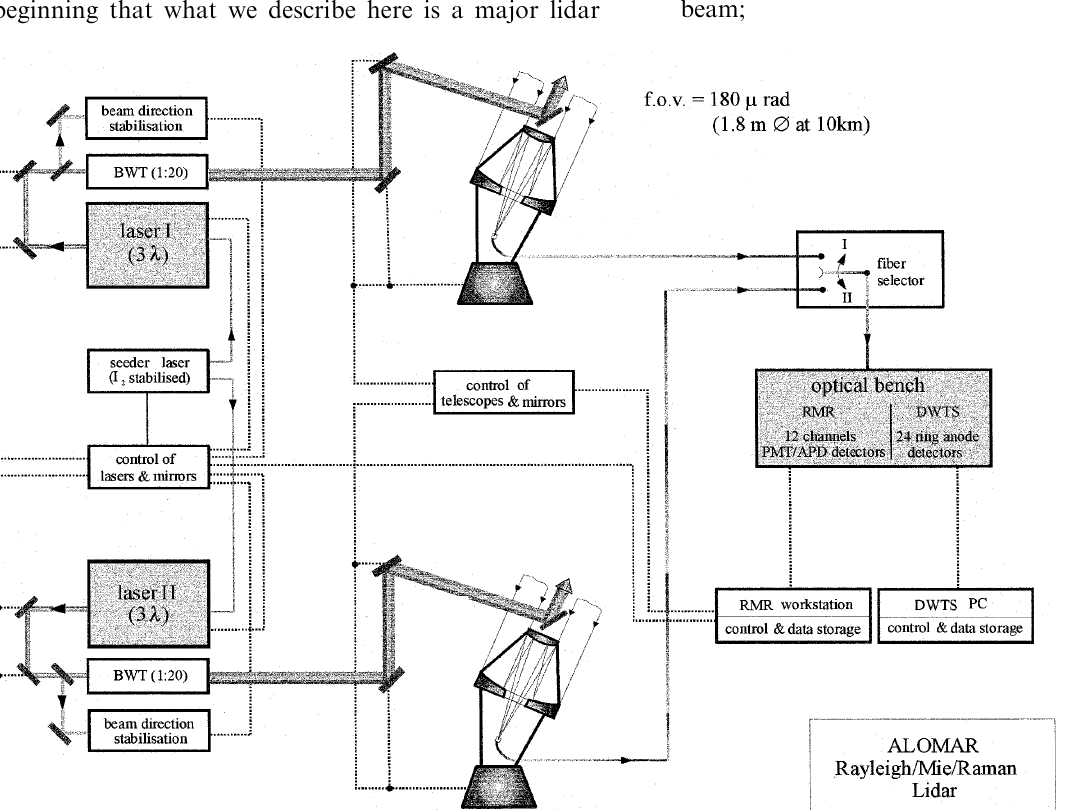
Fig. 1. A schematic of the major instrument subassemblies. A single cw laser is used to seed the two power lasers ( lasers I and II ); their laser beams are passed through the beam widening telescopes ( BWT ) to the top of the receiving telescopes from where they are emitted into